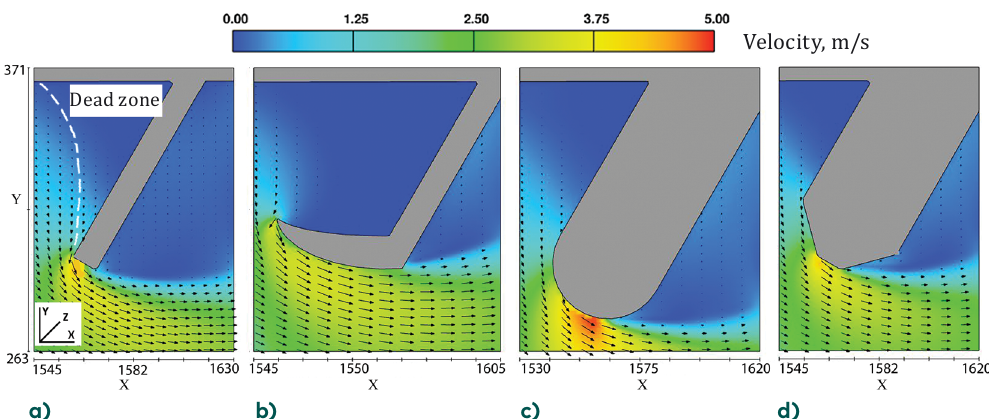
12. Velocity distribution at the height of 1 m from the floodplain bed for flow-splitting embankment at a 30° skew angle: a) vertical-wall;